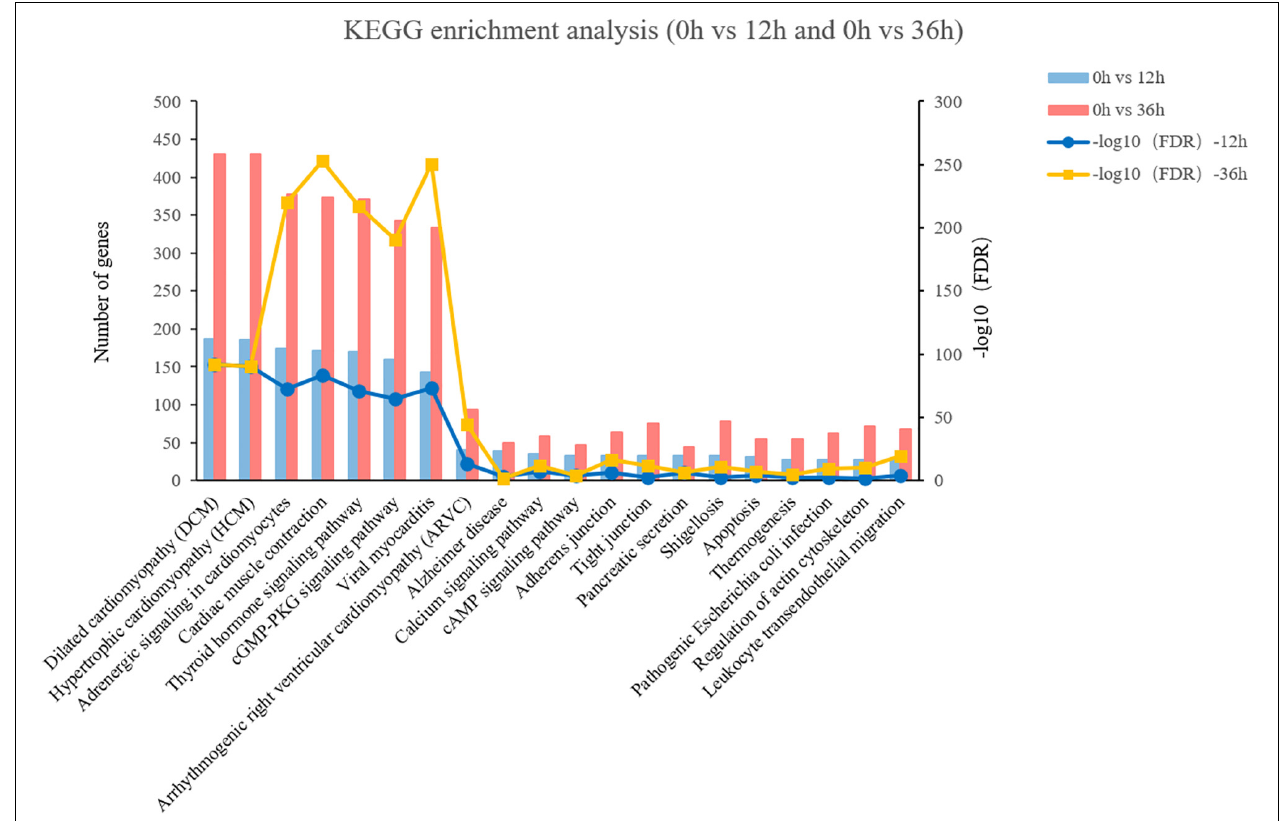
FIGURE 3 | The top 20 of the most enriched KEGG pathways of 0 vs. 12 h and 0 vs. 36 h in the transcriptome.